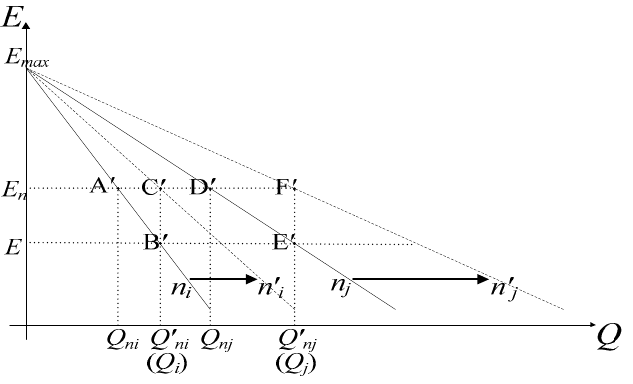
Figure 3. Conventional and improved Q - E droop control characteristics.